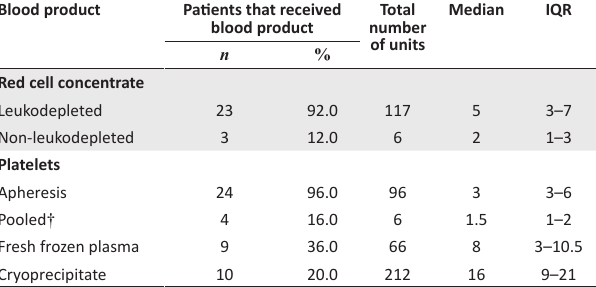
TABLE 4: Blood products administered to patients during the first 30 days of admission to Universitas Academic Hospital ( n = 25). Blood product Patients that received blood